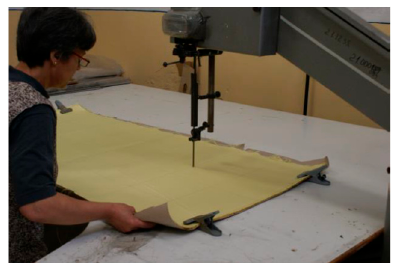
Figure 2. Cutting process of the layers for the ballistic package.